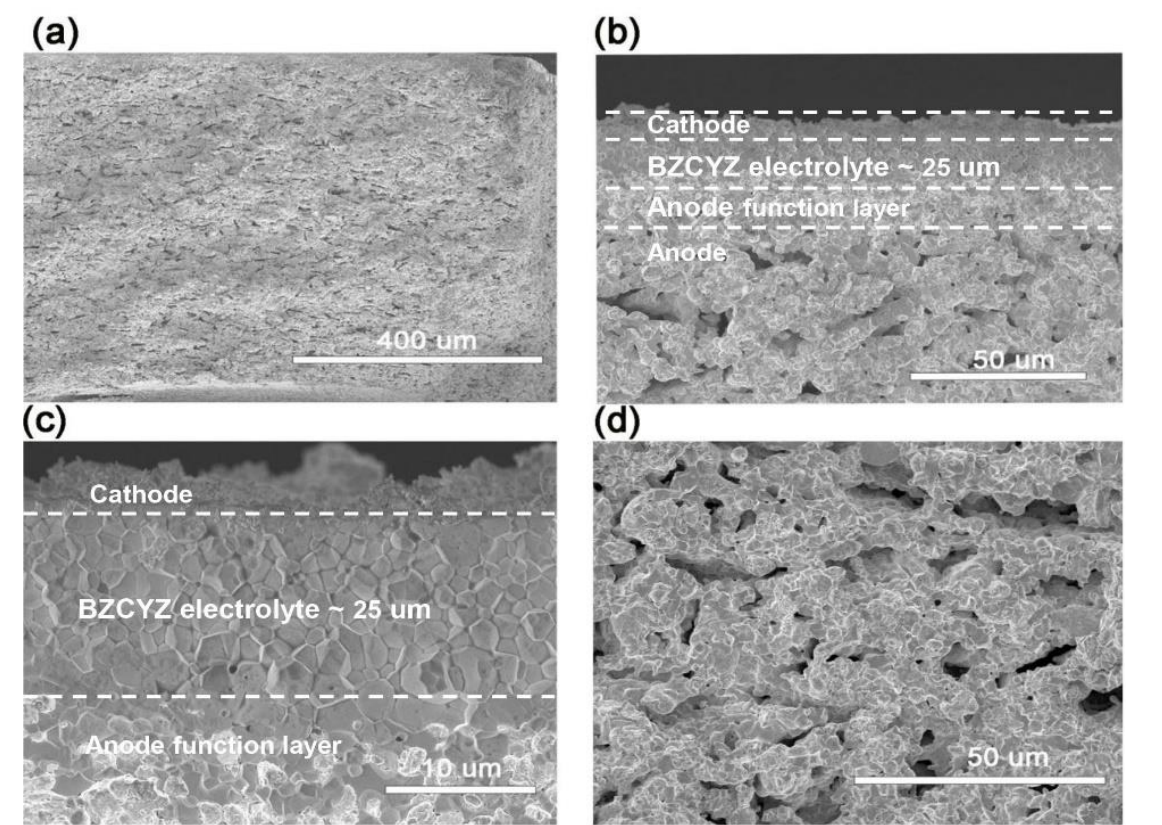
Figure 2. Cross-sectional SEM images of tubular fuel electrode for SOFC. ( a ) Overall cross-sectional microstructure. ( b ) Magnified view of cathode – electrolyte – anode functional layer – anode. ( c ) Magnified electrolyte microstructure. ( d ) Anode support microstructure.